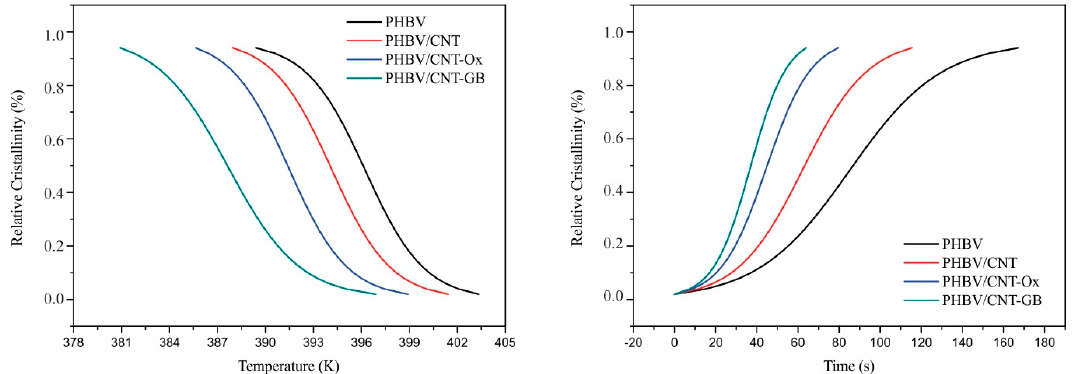
Figure 3. Relative crystallinity versus temperature (left) and time (right) for PHBV, PHBV/CNT, PHBV/CNT-Ox, and PHBV/CNT-GB, at the cooling rate of 5 °C/min. With the conversion fraction values for each temperature, the activation energy value for each conversion fraction can be found by plotting the logarithm of the heating rate by the inverse of the temperature. The activation energy is obtained through the angular coefficient of this curve using the Kissinger model. The activation energy curve versus the conversion fraction is shown in Figure 4. J. Compos. Sci. 2020 , 4 , x FOR PEER REVIEW 10 of 19